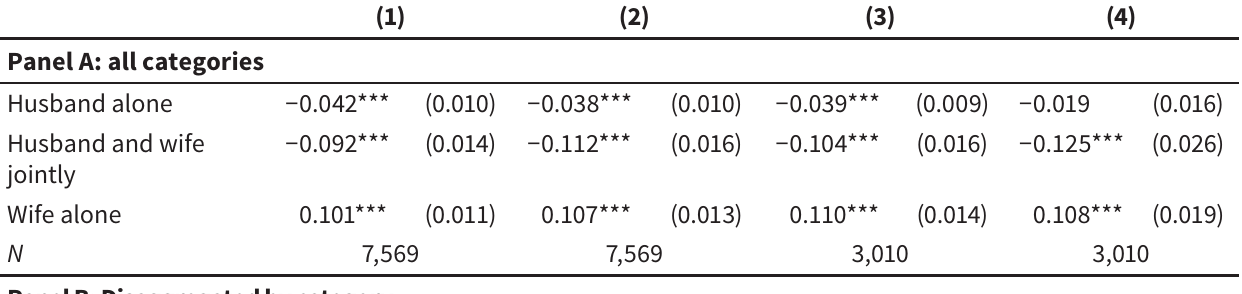
Shifts in decision-making power as the husband’s migrant status